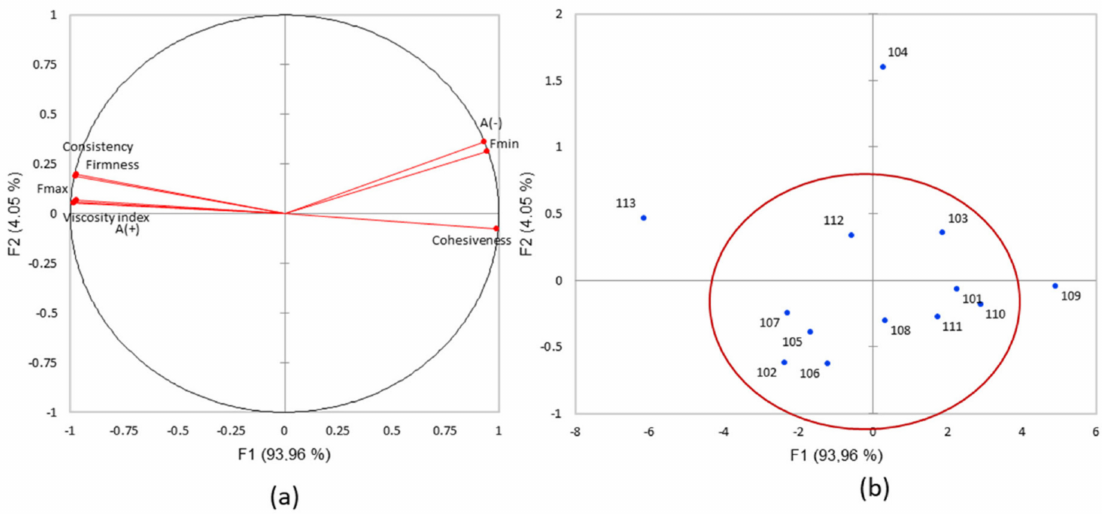
Figure 8. ( a ) PCA loading plot of the textural parameters (variables) and ( b ) scatter plot of the products (individuals) for the textural test (PC1 93.96%, PC2 4.05%).